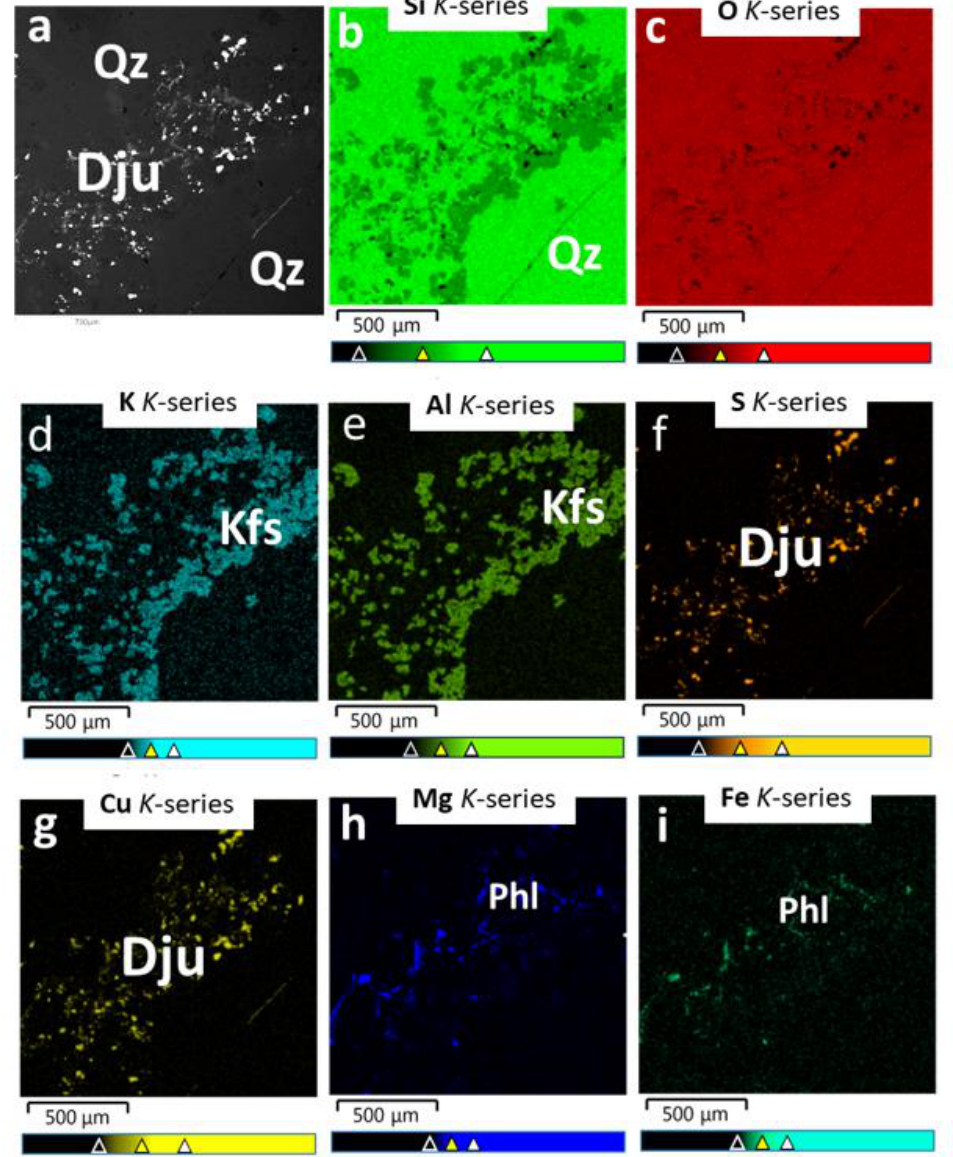
Figure 16. SE micrograph ( a ) at the edge of agate No 4 (Figure 4b,e) containing micro inclusions